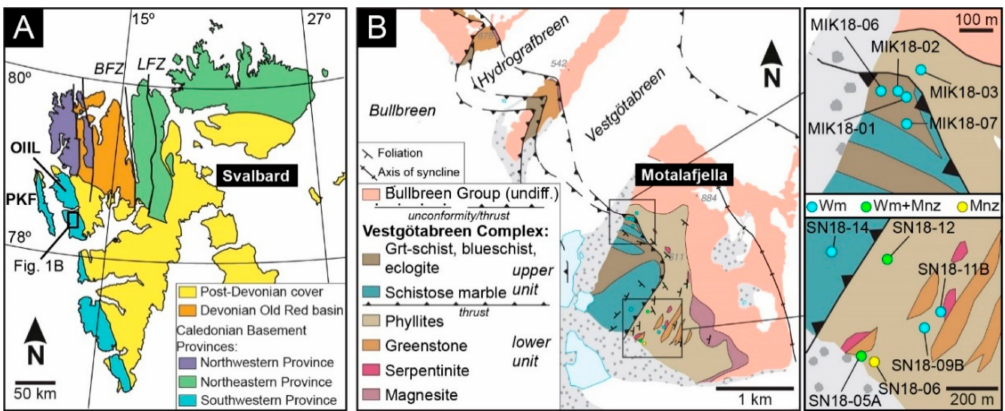
Figure 1. ( A ) Simplified map of Svalbard showing the exposures of the Caledonian Basement Terranes and the major strike-slip bounding faults, after Gee and Teben’kov [2]. ( B ) Geological bedrock map of the Vestgötabreen Complex and overlying Bullbreen Group sedimentary cover from Motalafjella nunatak towards the northwest in Oscar II Land, after Ohta et al. [15]. Representative orientations of the foliation planes and the location of the syncline axis are displayed after Labrousse et al. [16]. The areas in which samples were obtained are enlarged for clarity. Abbreviations: BFZ, Billefjorden Fault Zone; LFZ, Lomfjorden Fault Zone, OIIL, Oscar II Land; PKF, Prins Karls